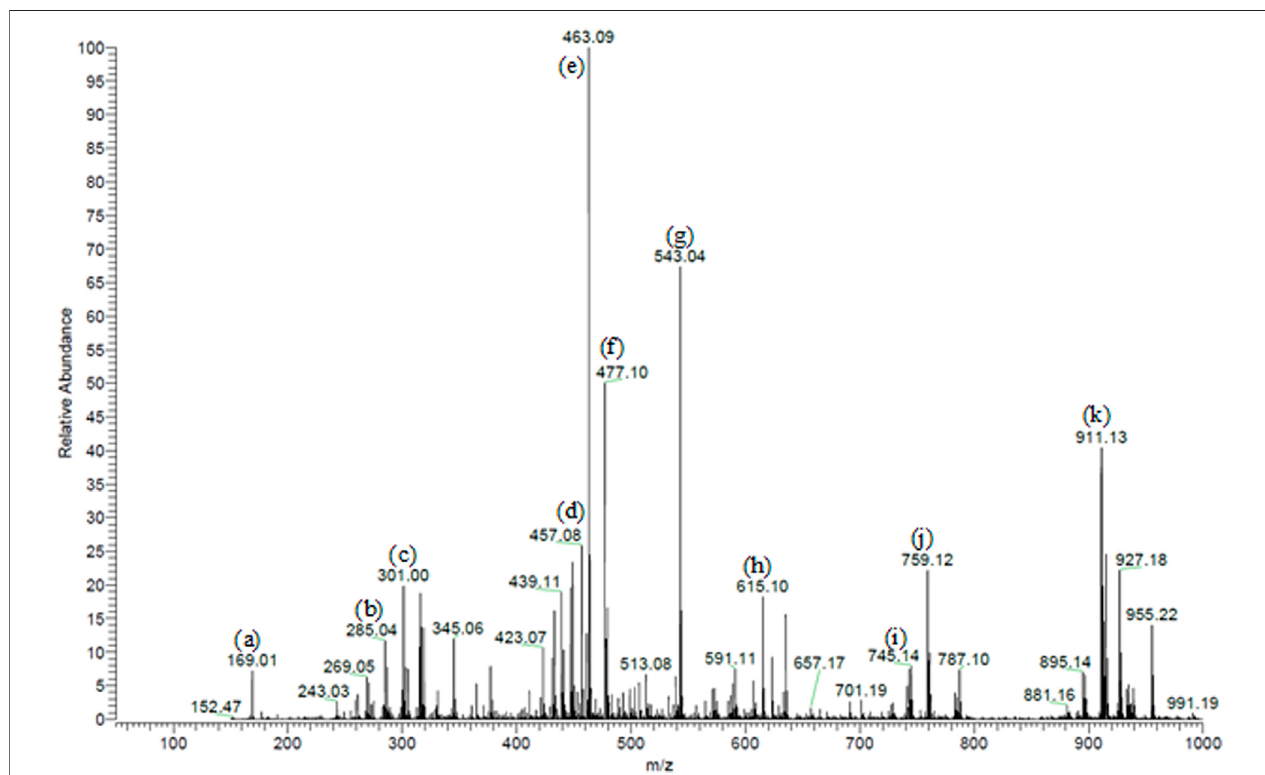
FIGURE 1 | Partial MS pro fi le of S. aqueum leaf extract in the negative-ion ESI/MS. (A) Gallic acid, (B) myrigalone-G, (C) ellagic acid, (D) EGCG, (E) myricitrin, (F) europetin 3-rhamnoside, (G) myricetin coumaroyl sulphate, (H) myricetin galloyl rhamnoside, (I) (epi)-gallocatechin-(epi)-catechin gallate (J) samarangenin A, and (K) samarangenin B.